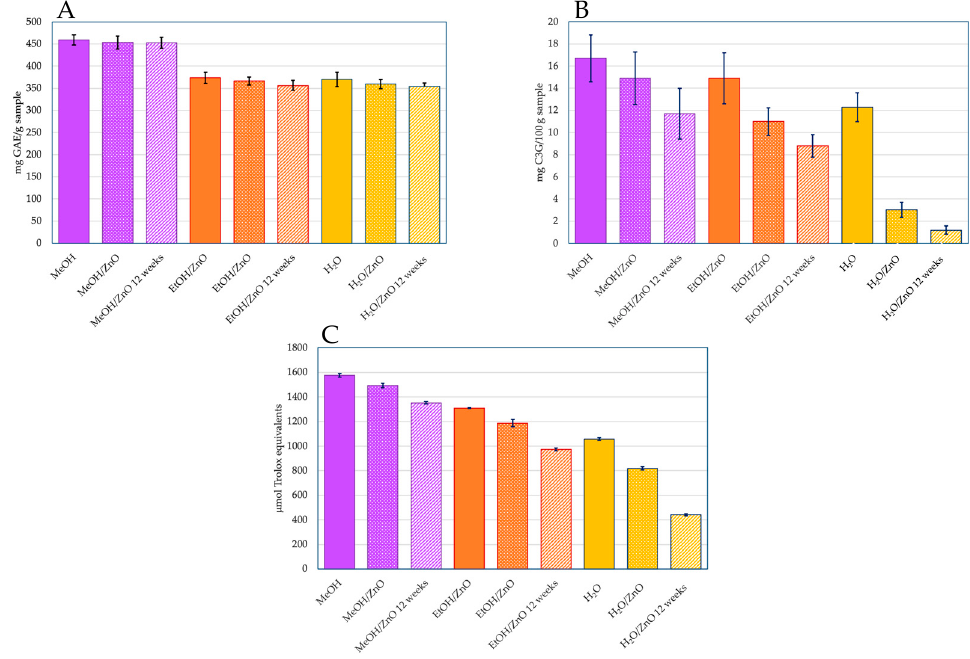
Figure 1. Comparison of total phenolic compounds ( A ), total monomeric anthocyanins ( B ), and antioxidant activity ( C ) of anthocyanins extracted from coffee ( Coffea arabica L.) husks with MeOH, EtOH or water (H 2 O) versus anthocyanins attached to zinc oxide nanoparticles (initial and after 12 weeks). The data shown correspond to means ± standard deviations (n = 3).